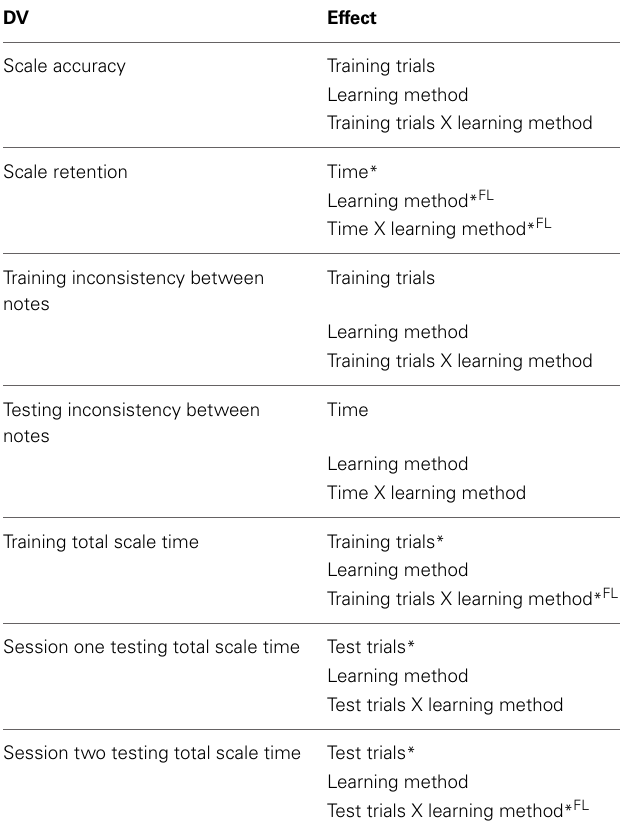
Table 2 | Summary of Experiment 2